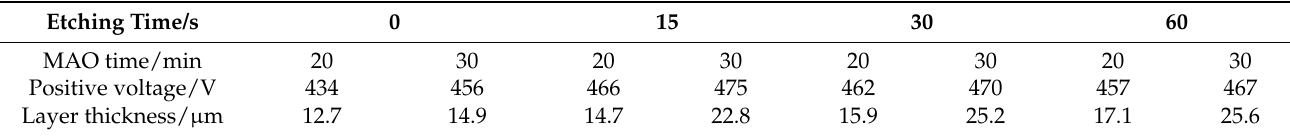
Table 1. The positive voltage and layer thickness for Al-12 Si by different pretreatment and MAO